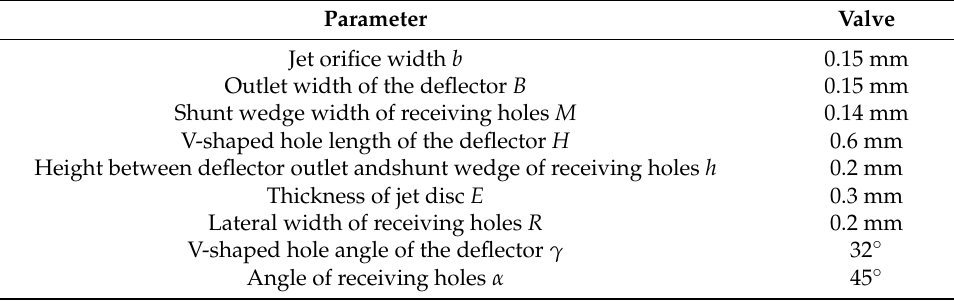
Figure 6. The fluid domain model of the prestage. Table 2. The parameters of structure.